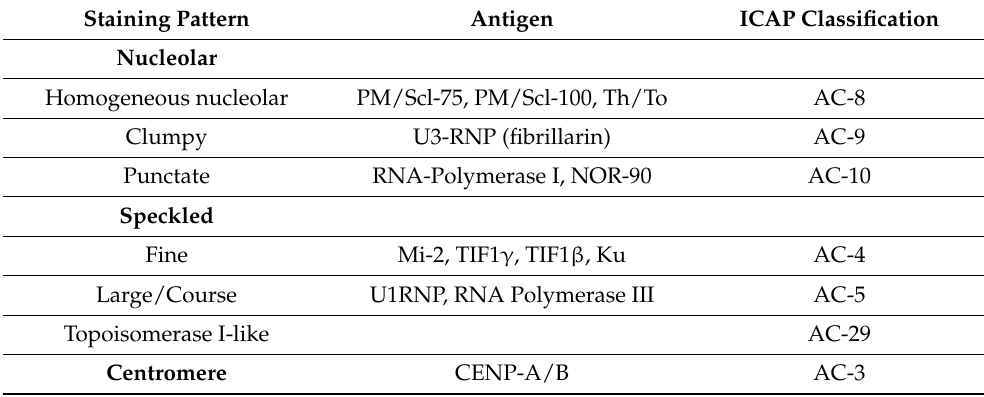
Table 1. Summary of antinuclear antibody staining patterns on indirect immunofluorescence, their associated antigens, and their ICAP